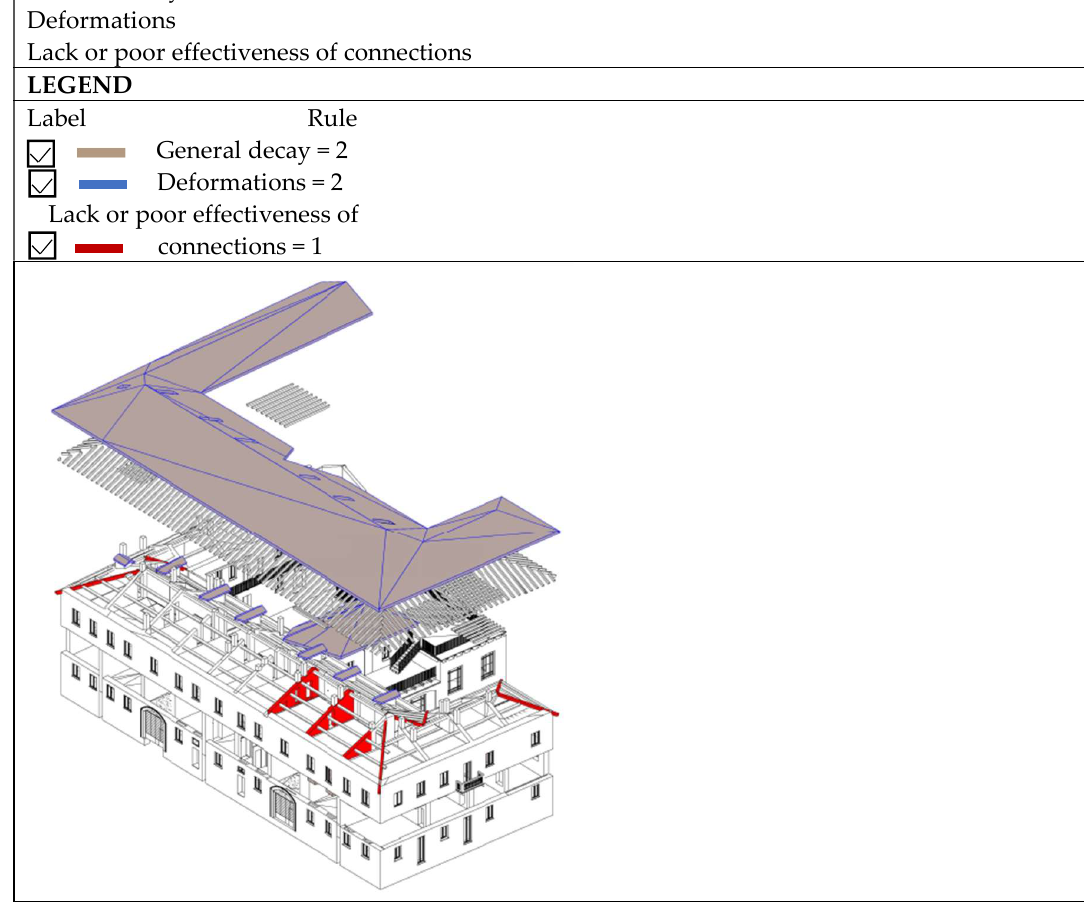
Figure 12. Multiple queries: presence of multiple vulnerabilities with different weights on the same element of the system. The coloring identifies the elements affected by all 3 vulnerabilities in the legend with their weights.